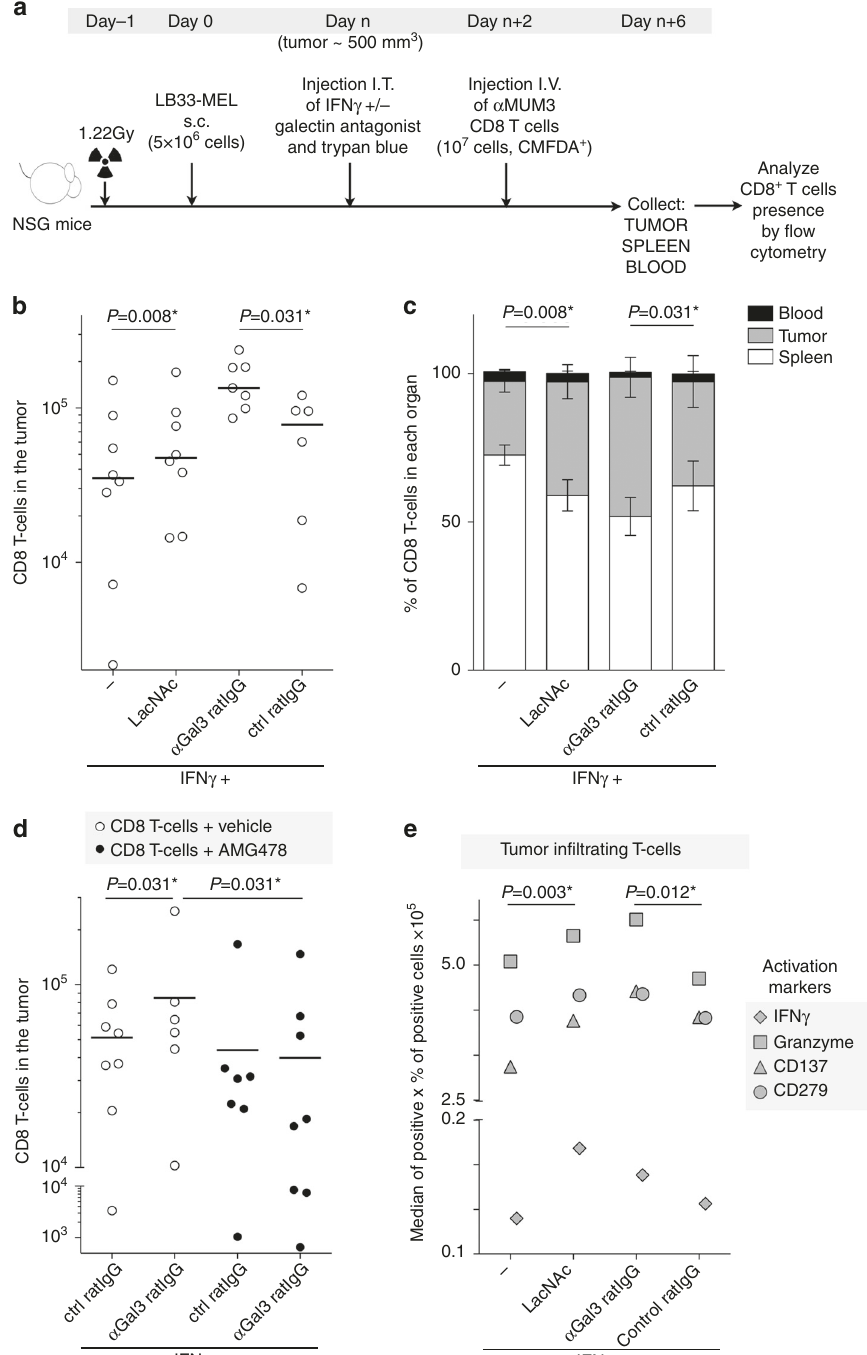
Fig. 7 Anti-galectin treatments boost CD8 + T-cell in fi ltration in the tumor. a Scheme showing the protocol for analysis of T-cell in fi ltration in the tumor. s.c. stands for subcutaneous injection, I.T. for intratumoral injection, and I.V. for intravenous injection. The doses used for I.T. were IFN γ 50 ng per tumor, LacNAc 0.1 μ mol per tumor, and antibodies 100 ng per tumor. b Absolute numbers of CD8 + T cells in fi ltrating the tumors of mice treated as explained above. Each point represents one mouse (average of quadruplicates). Lines represent the mean value for each treatment. Wilcoxon matched-pairs signed rank test. P -values are shown in the graph. Absolute numbers of CD8 + T cells in the spleens are shown in Supplementary Fig. 9a; n = 6 – 8 mice per group. c Percentage of CD8 + T cells found in the different compartments. Bars represent the mean ± SEM of 6 – 8 mice per group. Wilcoxon matched-pairs signed rank test. P -values regarding tumor and spleen proportions are shown in the graph. d Absolute numbers of CD8 + T cells in fi ltrating the tumors of mice treated or not with the CXCR3 inhibitor AMG478. Each point represents one mouse (average of quadruplicates). Lines represent the mean value for each treatment. Wilcoxon matched-pairs signed rank test. P -values are shown in the graph. Absolute numbers of CD8 + T cells in the spleens are shown in Supplementary Fig. 9a; n = 6 – 8 mice per group. e Global activation status of tumor in fi ltrating CD8 + T cells. Each symbol represents the mean value for the different activation markers ( n = 6 – 8 mice per group). Wilcoxon matched-pairs signed rank test. P -values are shown in the graph. Representative histograms are shown in Supplementary Fig.